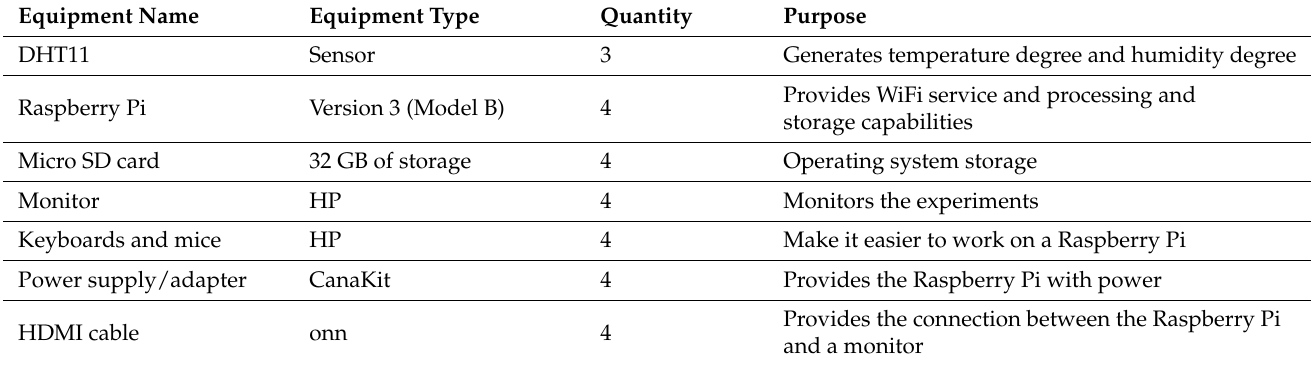
Table 1. Complete list of the hardware utilized in the IoT–Fog–Cloud architecture.